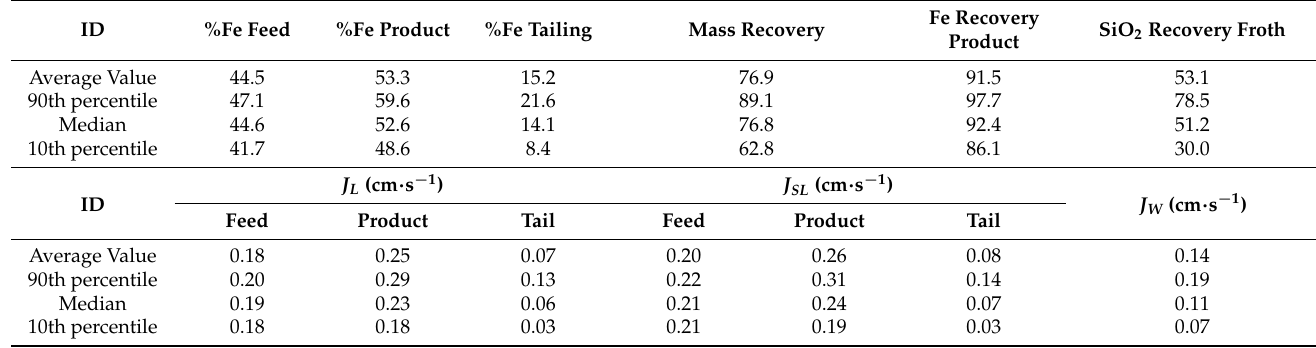
Figure 15. Results concerning the Fe and SiO 2 recoveries during the pilot tests. Table 6. Summary of results for 67 pilot